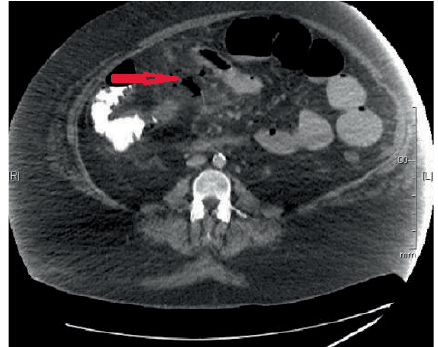
Figure 7: CT contrast scan depicting free air in pocket of abscess where bowel was perforated (short red